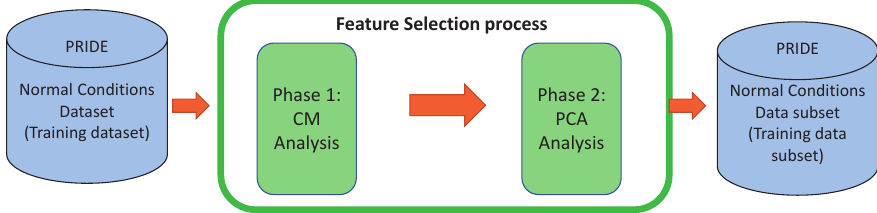
Figure 1. Feature selection process performed over every user of the PRIDE training